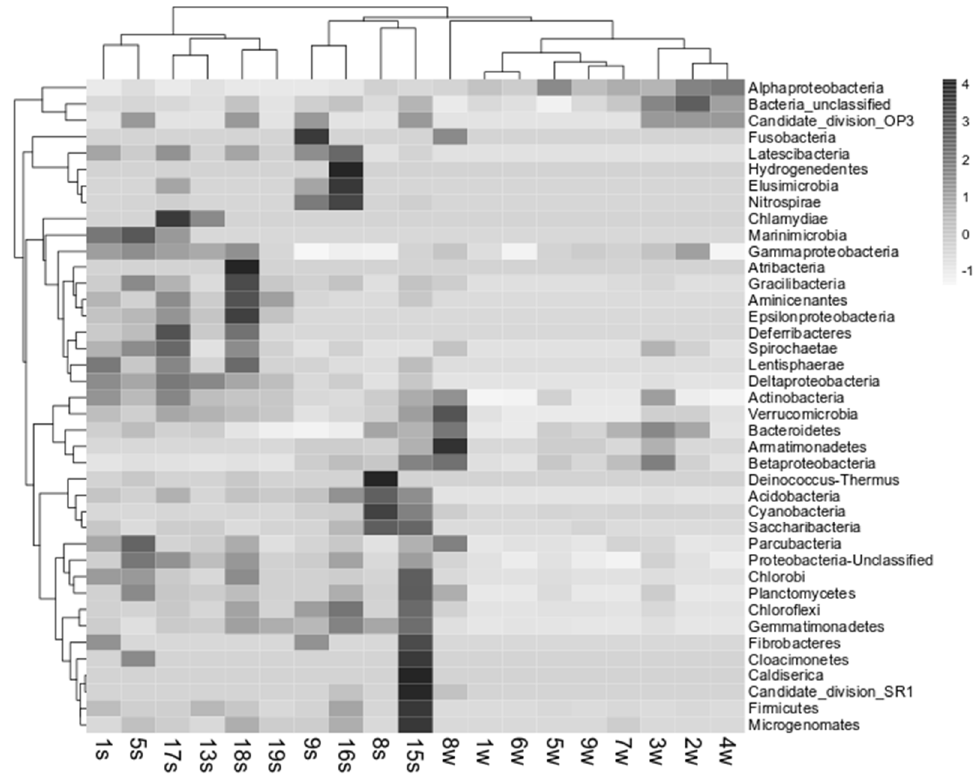
Figure 6. Heat map associated with cluster analysis and based on main OTUs retrieved in water and sediment samples from the Pasvik River.